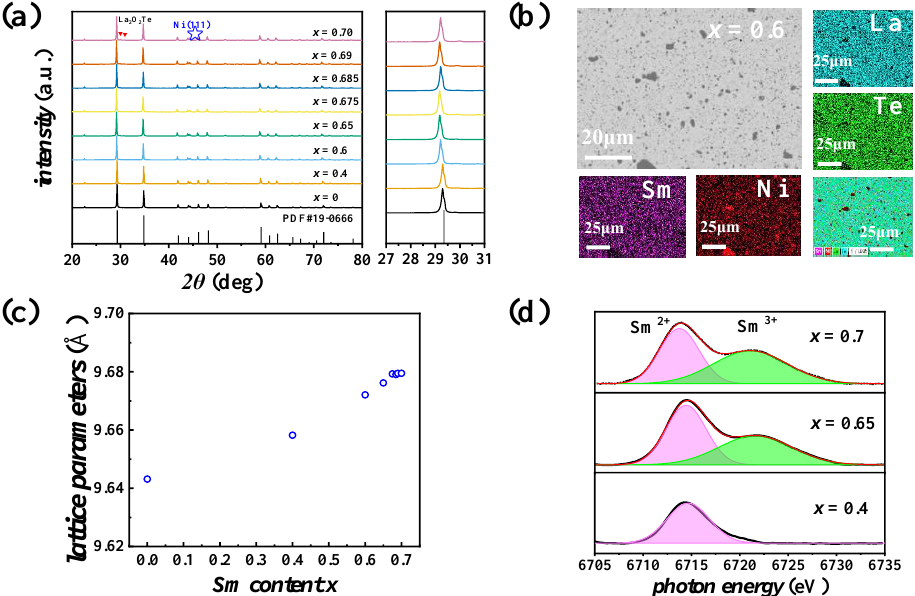
Figure 1. ( a ) PXRD patterns of the as-synthesized La 3 − x Sm x Te 4 ( x = 0, 0.4, 0.6, 0.65, 0.675, 0.685, 0.69, 0.7)/10 vol.% Ni composites. ( b ) Backscattered electron microscopy (BSE) image and elemental mappings for the as-synthesized La 2.4 Sm 0.6 Te 4 /10 vol.% Ni. ( c ) Lattice parameters of as-synthesized La 3- x Sm x Te 4 as a function of Sm content. ( d ) XAS spectra of La 2.6 Sm 0.4 Te 4 , La 2.35 Sm 0.65 Te 4 , and La 2.3 Sm 0.7 Te 4 composited with 10 vol.% Ni.